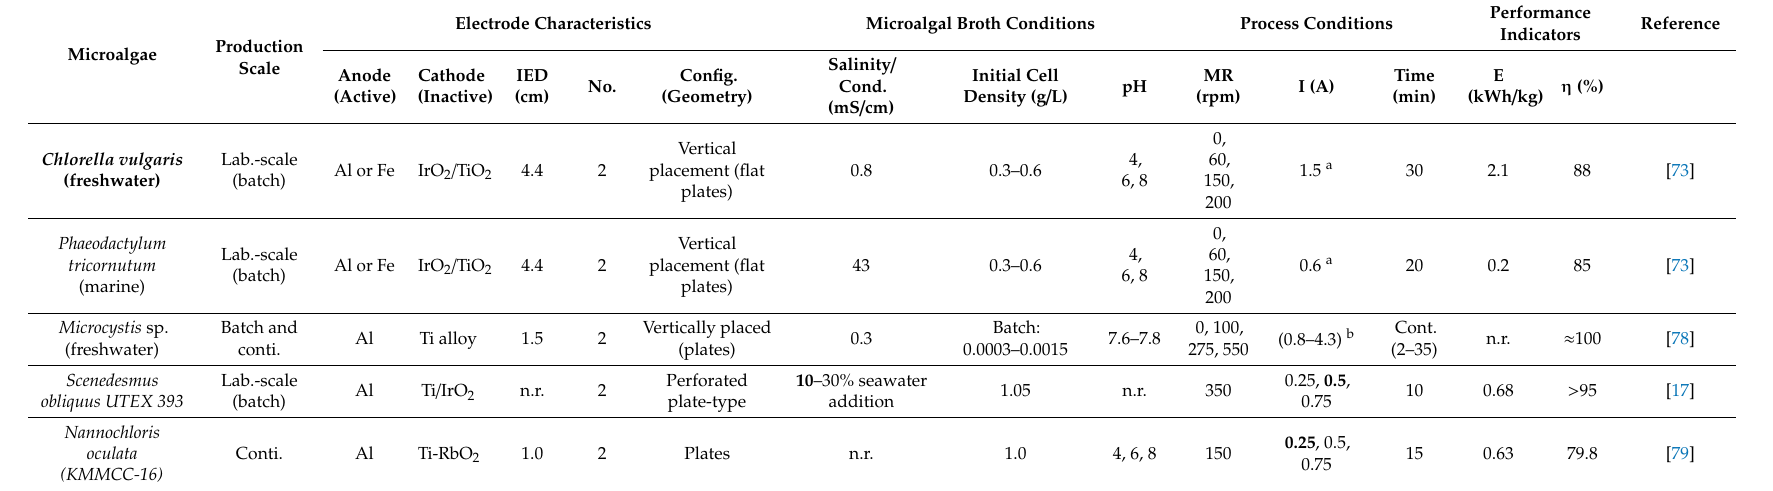
Table 6. Set of conditions utilized in dewatering of microalgae via electroflotation for microalgal